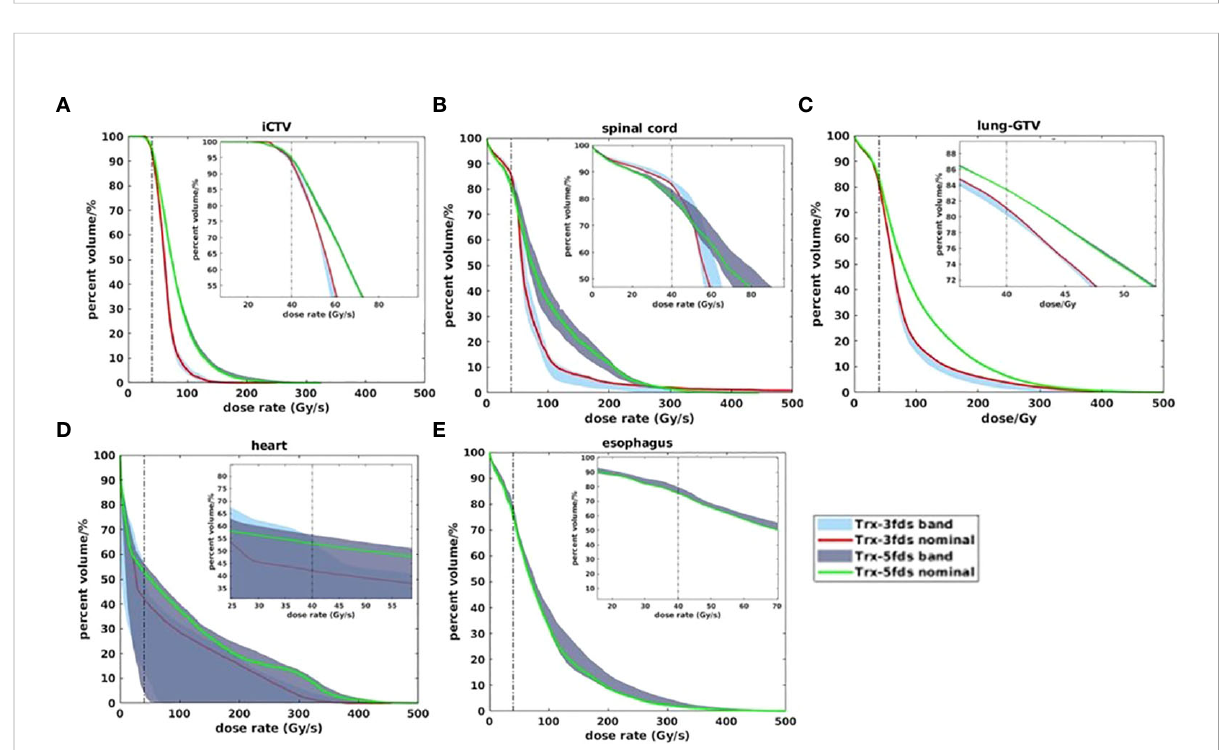
FIGURE 7 DRVH bands for different RT structures for Trx-3fds and Trx 5fds for patient #1, target iCTV (A) and OARs spinal cord, lung-GTV, heart, and esophagus (B – E)